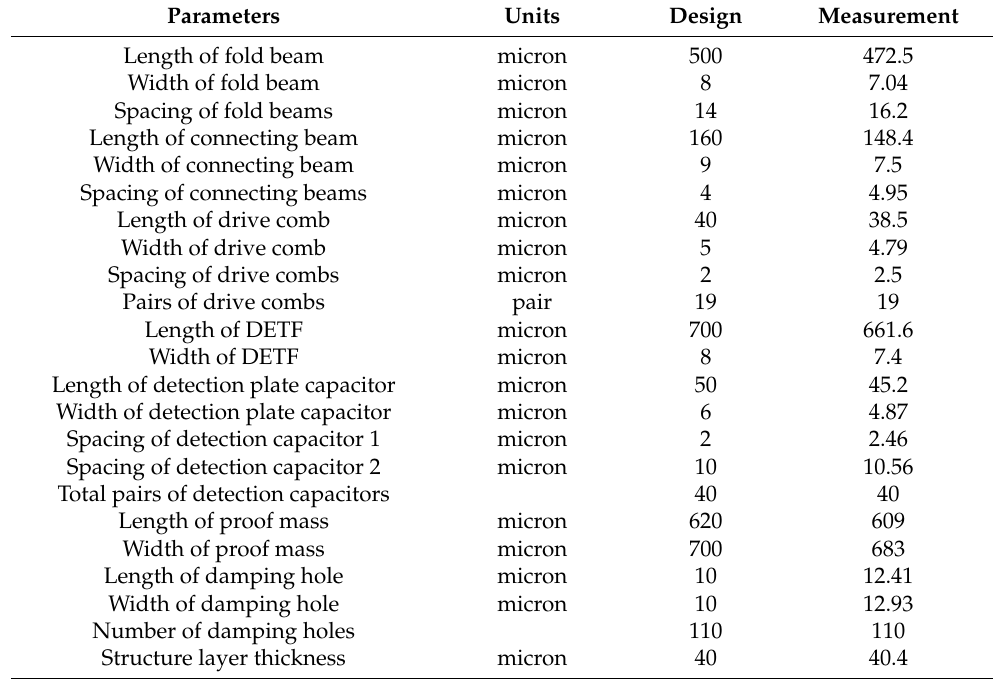
Figure 4. The design of the MEMS accelerometer. Table 1. Structural parameters of the